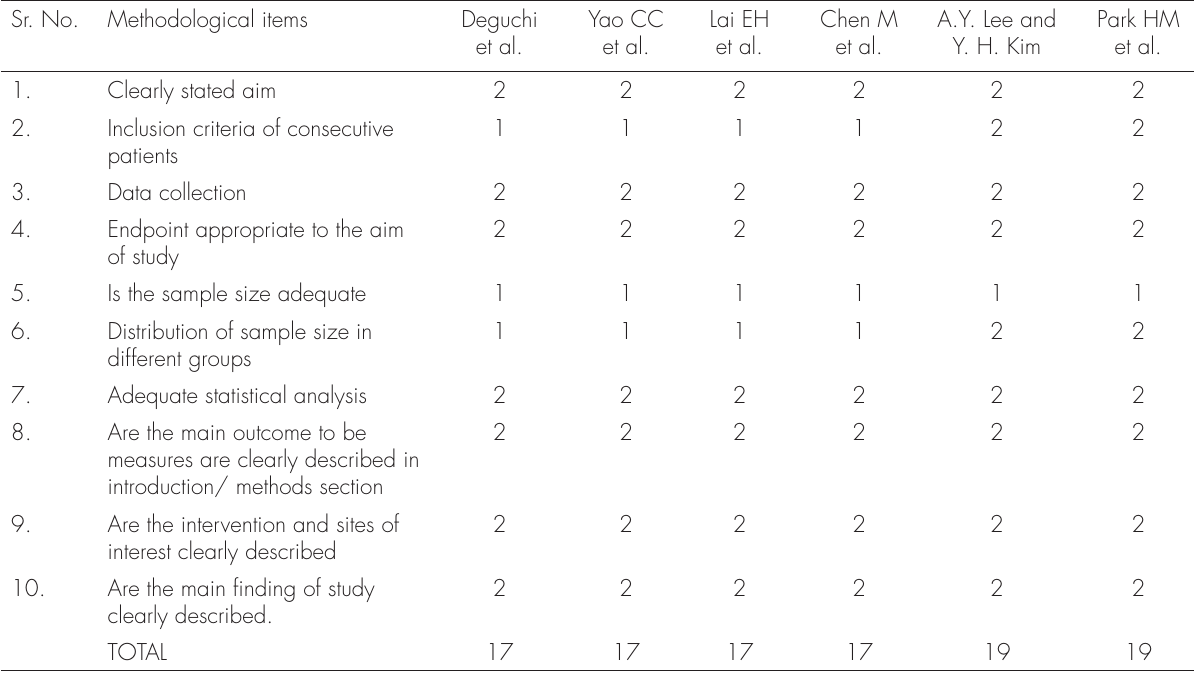
Table III. Quality of studies when mini-implants are compared with extra oral anchorage devices.